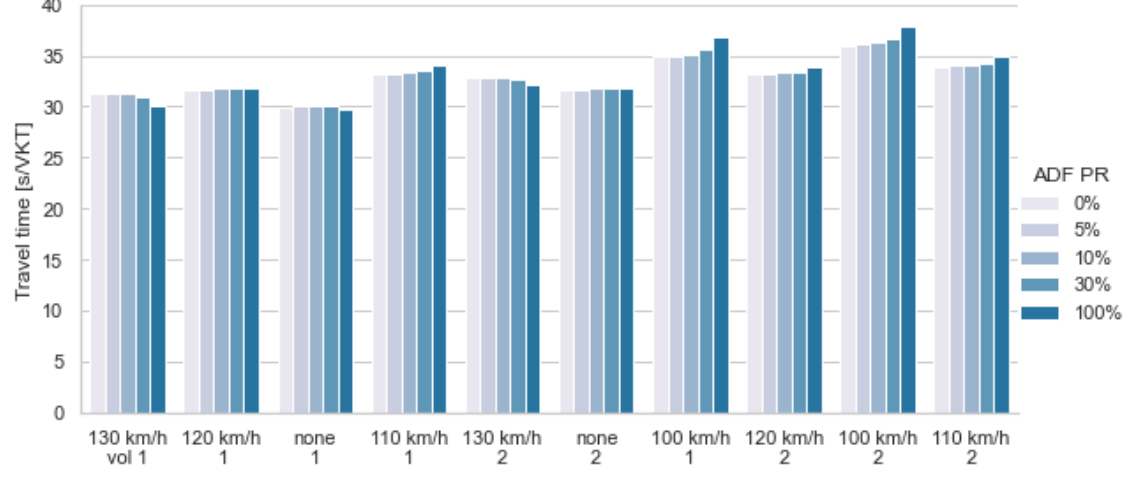
Figure 6. Average travel time in seconds per VKT for the most common combinations of speed limit and traffic volume class (indicated below bars) by penetration rate among passenger cars on EU27+3 motorways. Volume class 1: up to 750 veh/h/lane; 2: 751–1250 veh/h/lane. Figure 7 shows the average delay in these most common speed limit and traffic volume combinations. At a speed limit of 130 km/h, the average delays are lower with AVs than at baseline (by 33.9% and 14.1% at traffic volumes of up to 750 and 1250 veh/h/lane, respectively) and higher than at baseline especially at speed limits of 100 to 110 km/h (by 21.5–85.6%). Here it should be noted that the absolute values of delay are small at low traffic volumes.